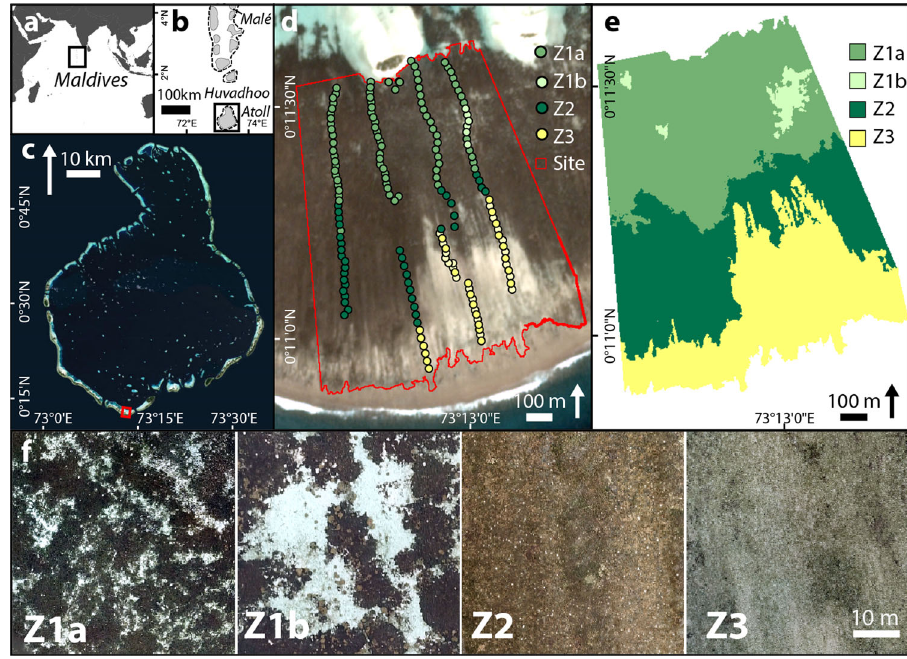
Fig. 2 Study site and seagrass zones. Locations of a the Maldives within the Indian Ocean (imagery: ESRI, 2020 61 ); b Huvadhoo Atoll within the southern Maldives; c the study site within Huvadhoo Atoll; and d the site area (in red) and ground truth points within each zone (PlanetScope satellite imagery 62 ). e Classi fi cation of seagrass zones.